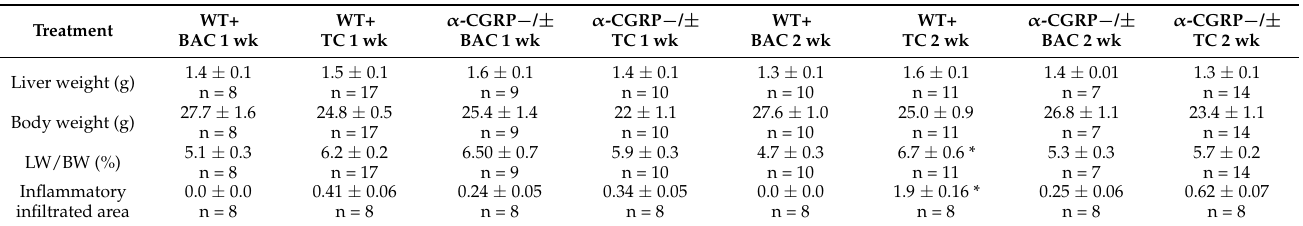
Table 1. Assessment of liver weight, body weight, and liver-to-body weight ratio. Evaluation of IBDM and Biliary